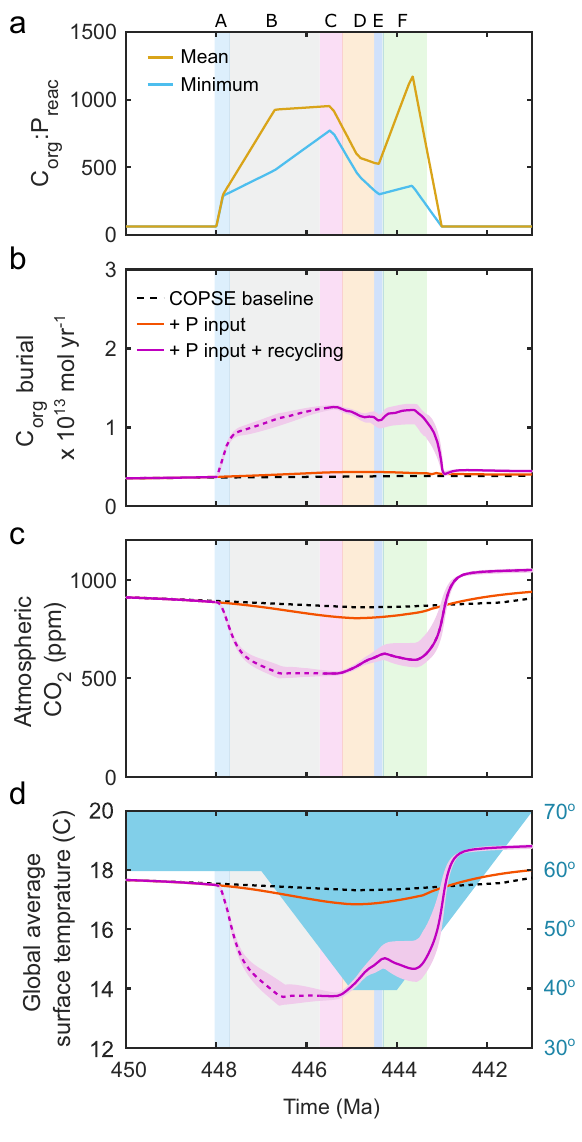
ratios again increased across the Yangtze Sea transect, suggesting a reintensi fi cation of P recycling back to the water column (Fig. 2).